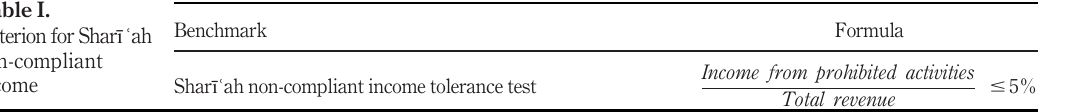
Table I. Criterion for Shar ī ʿ ah non-compliant